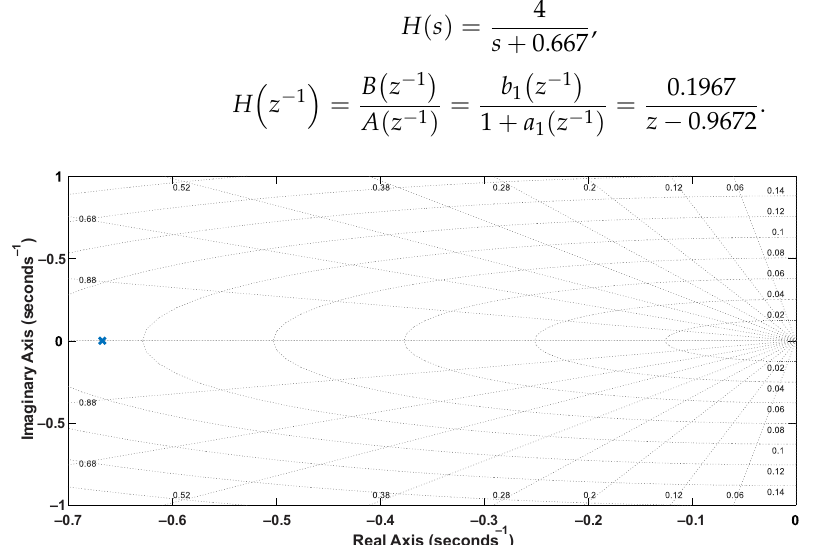
Real Axis (seconds ) –1